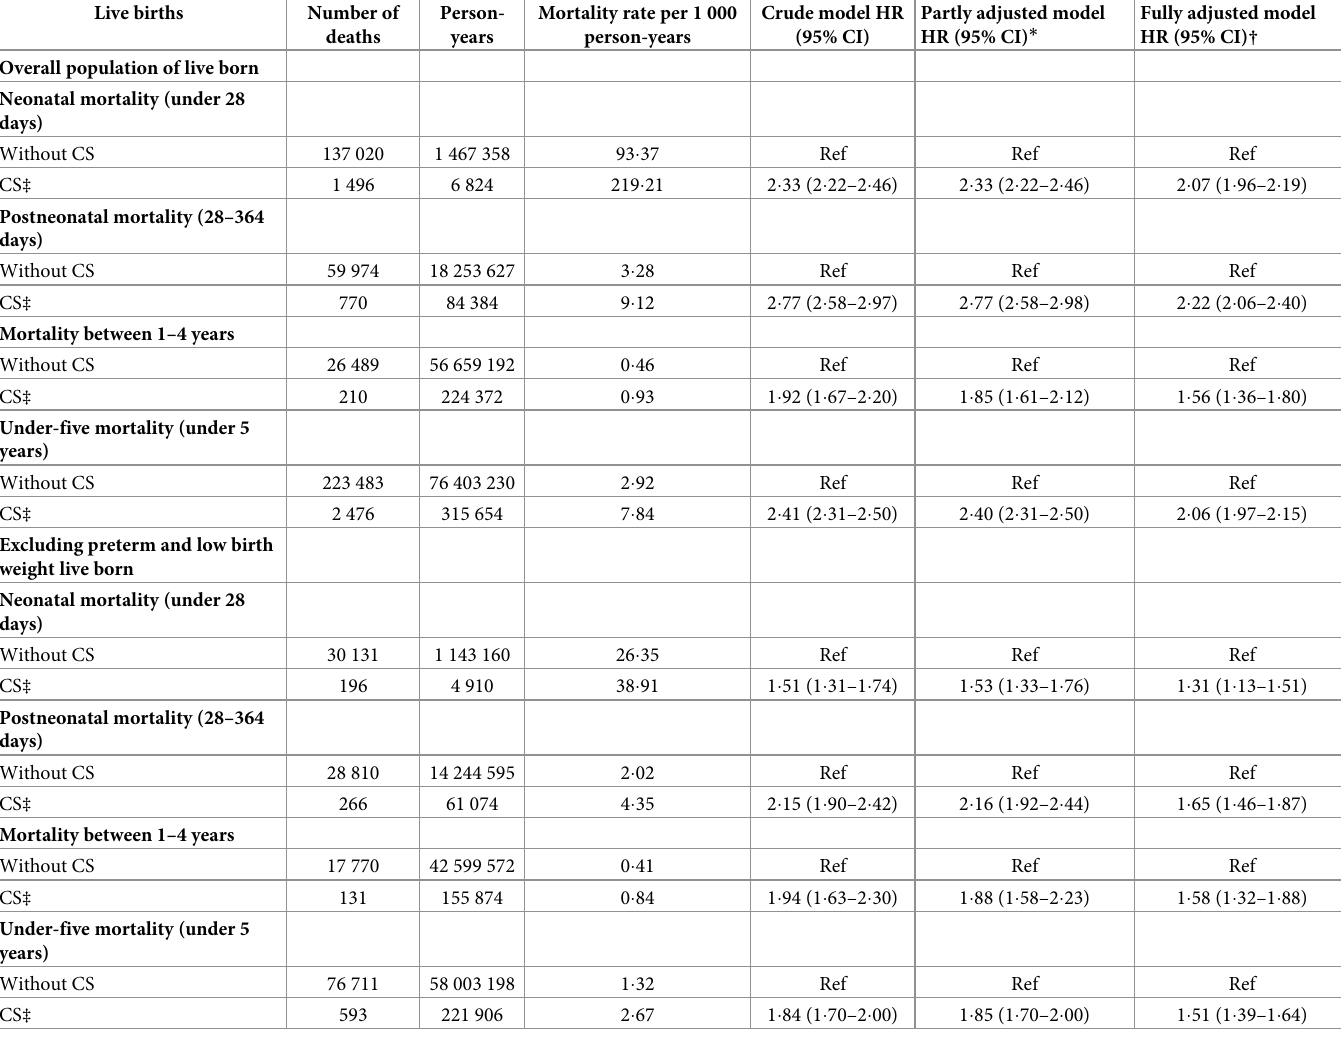
Table 2. Mortality risk by age group among singleton live births in the cohort-linked data, Brazil, 2011–2017. Live